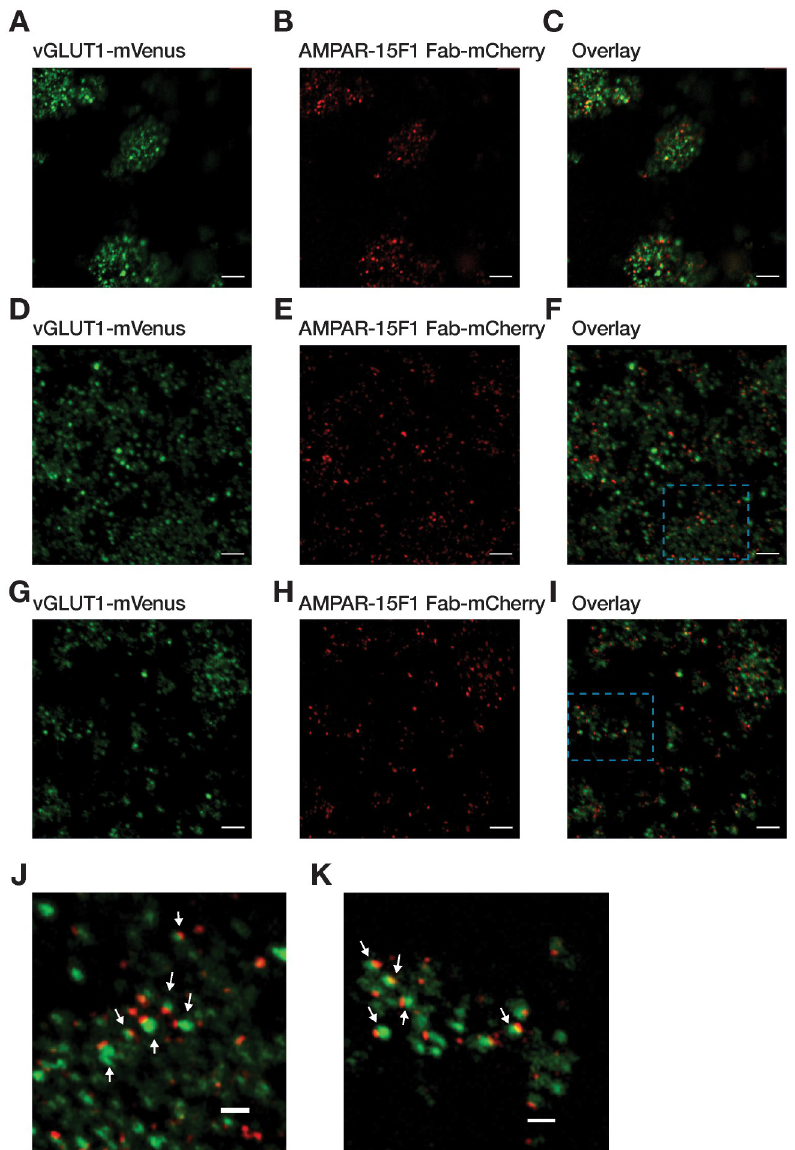
Fig 3. Cryo-LSM images of glutamatergic synaptosomes on cryo-EM grids isolated using (A-C) sucrose, (D-F) Ficoll and (G-I) Percoll density gradient centrifugation. Fluorescence signals of vGLUT1-mVenus and AMPAR-15F1 Fab- mCherry at the pre and postsynaptic compartments of synaptosomes are in the green and red channel, respectively. Zoomed-in images of glutamatergic synaptosomes prepared using (J) Ficoll and (K) Percoll density gradient centrifugation corresponding to areas enclosed in cyan dashed box in (F) and (I). Glutamatergic synaptosomes are highlighted with white arrows. Scale bar in (A-I): 5 μ m; scale bar in (J,K): 2 μ